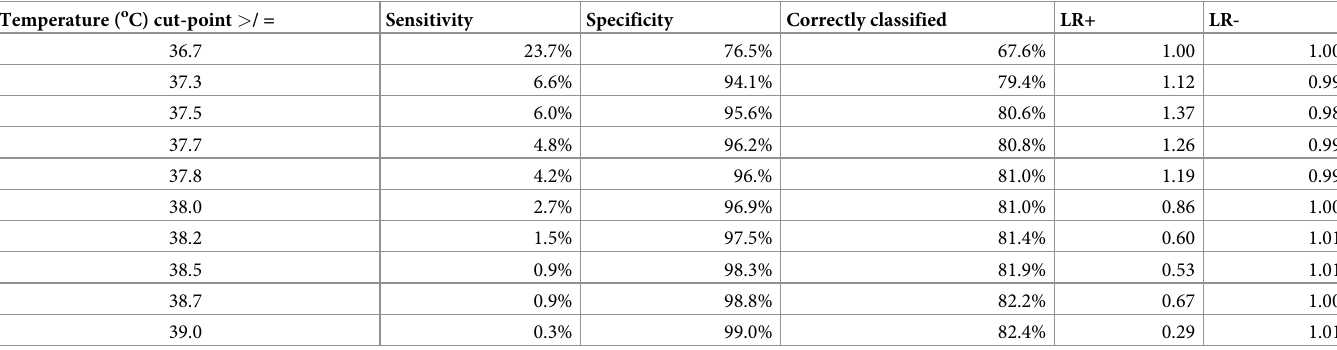
Table 4. Receiver operator characteristics of temperature